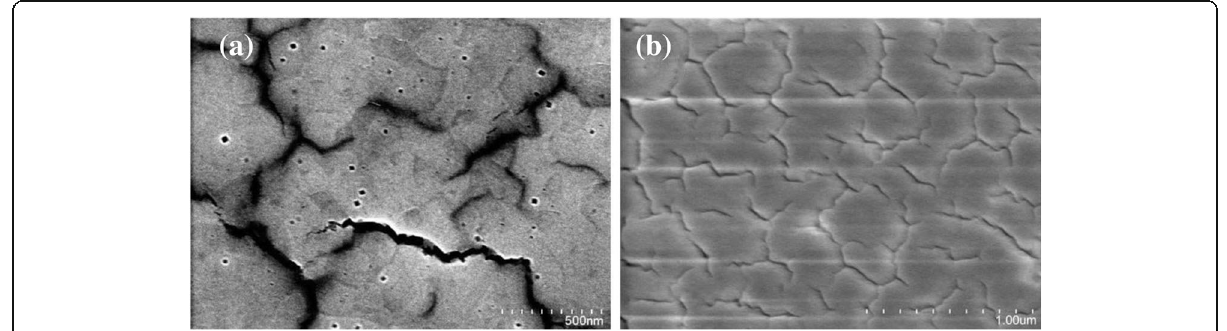
Fig. 3 SEM image of fabricated MAPbBr 3 film treated a at 100 °C and b at 75